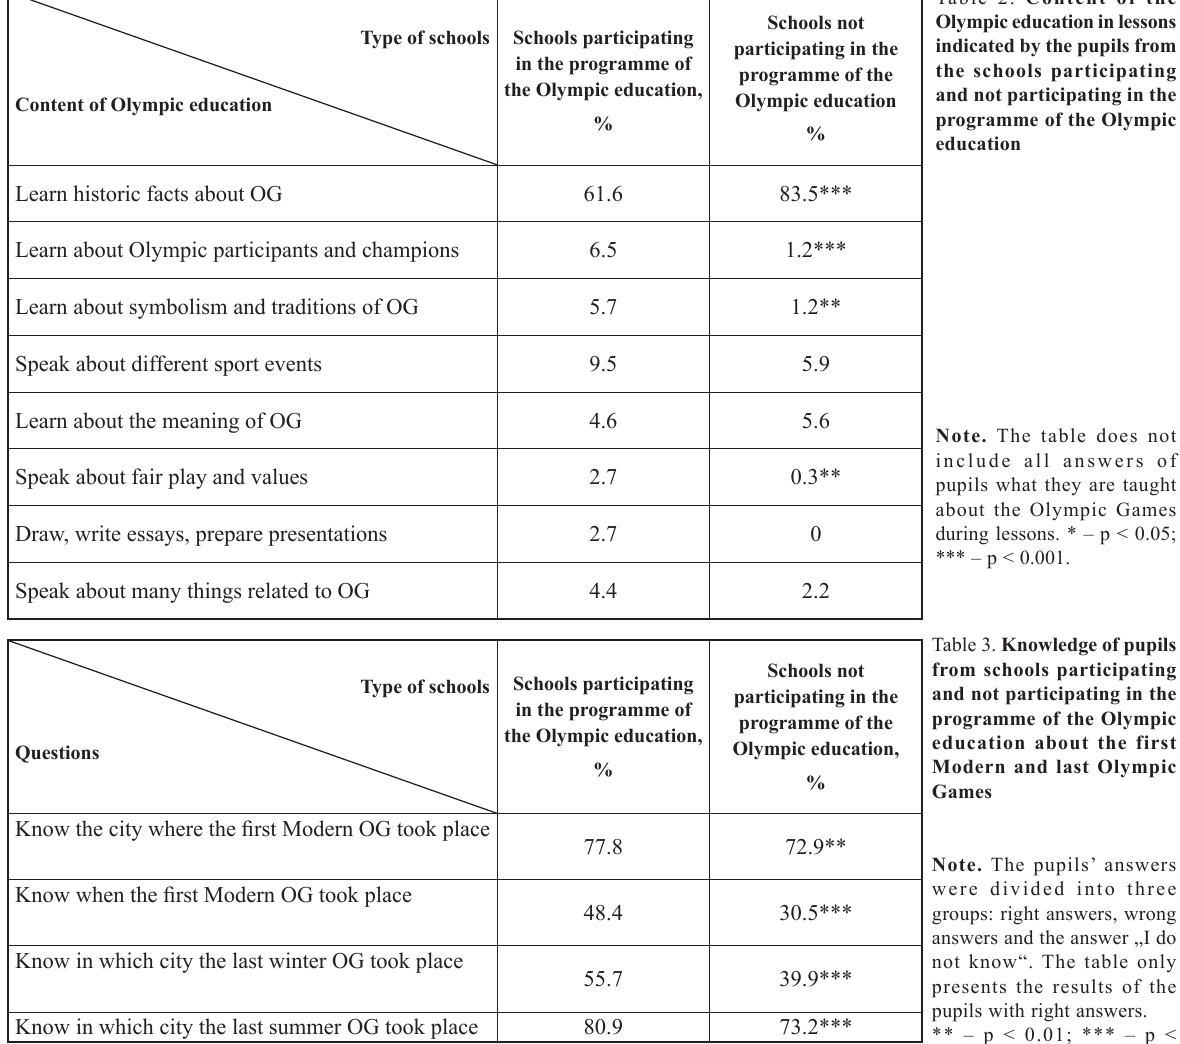
Table 3. Knowledge of pupils from schools